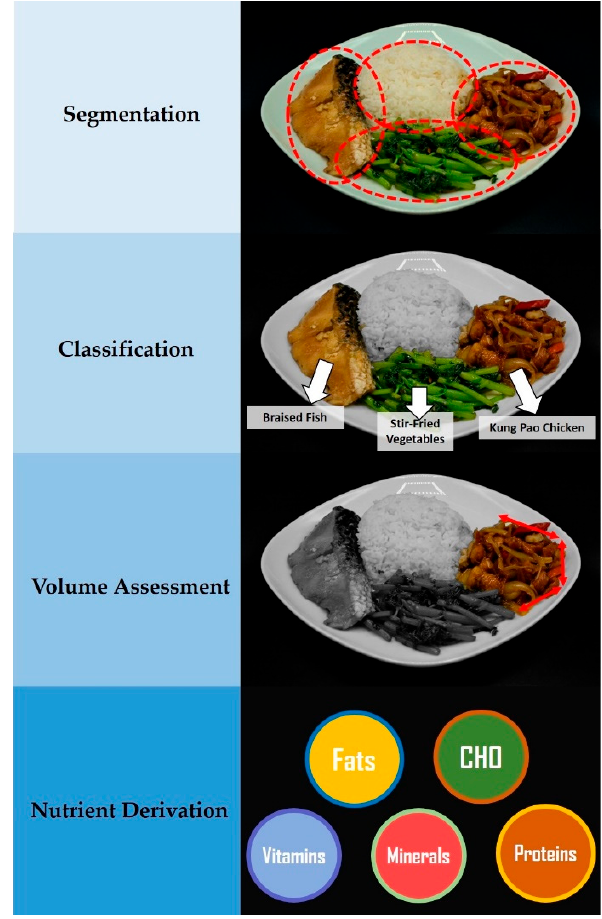
Figure 1. Anillustrationofthevariousstepsofimage-basedautomateddietaryassessment—Segmentation, Figure 1. An illustration of the various steps of image-based automated dietary assessment— Classification, Volume Assessment and Nutrient Segmentation, Classification, Volume Assessment and Nutrient Derivation.